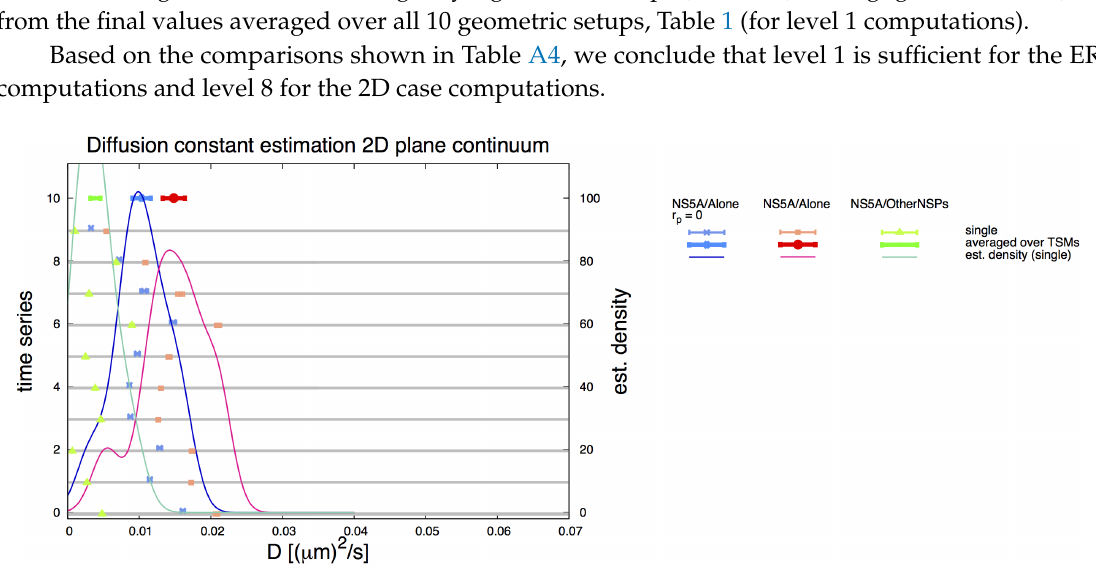
), ns5a | r p = 0 ), i.e., ns5a